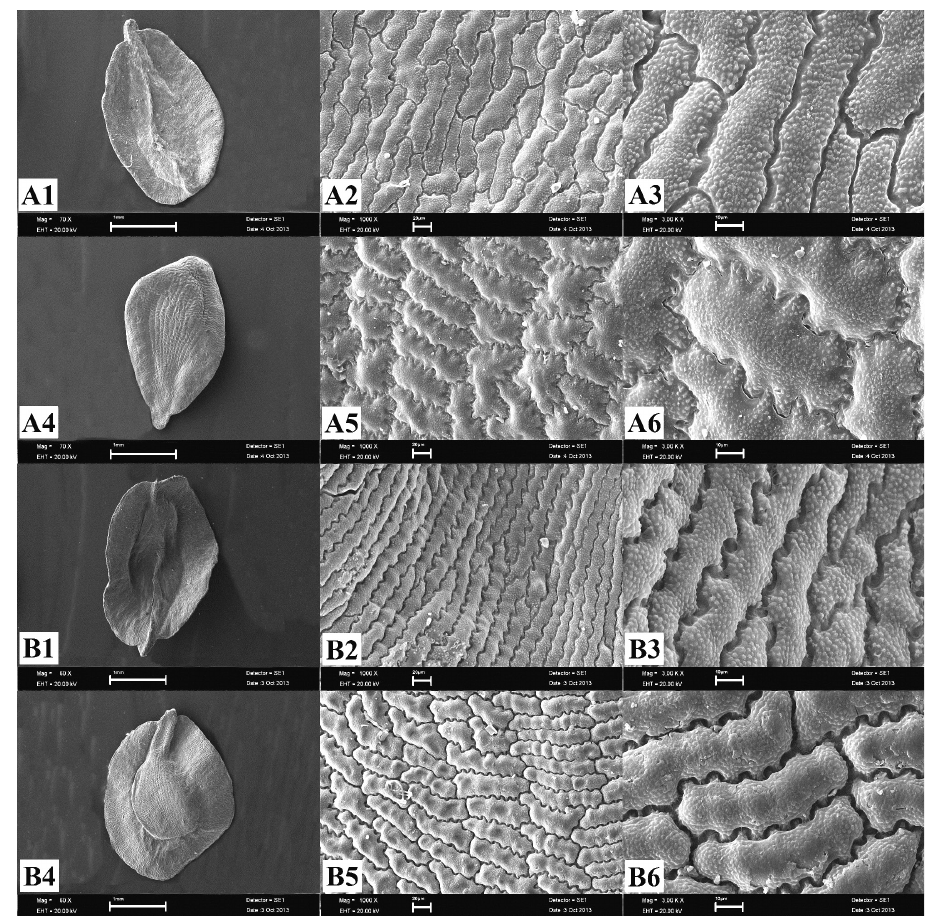
Figure 2. SEM photographs of the seed coat. A Dianthus aticii B D. zonatus 1–3 dorsal surface 4–6 ventral surface (scale bars: 1 and 4 : 1 mm, 2 and 5 : 20 μm, 3 and 6 : 10 μm). Seed morphology. Seeds of Dianthus aticii are elliptical, 2–3 × 1.4–2 mm,